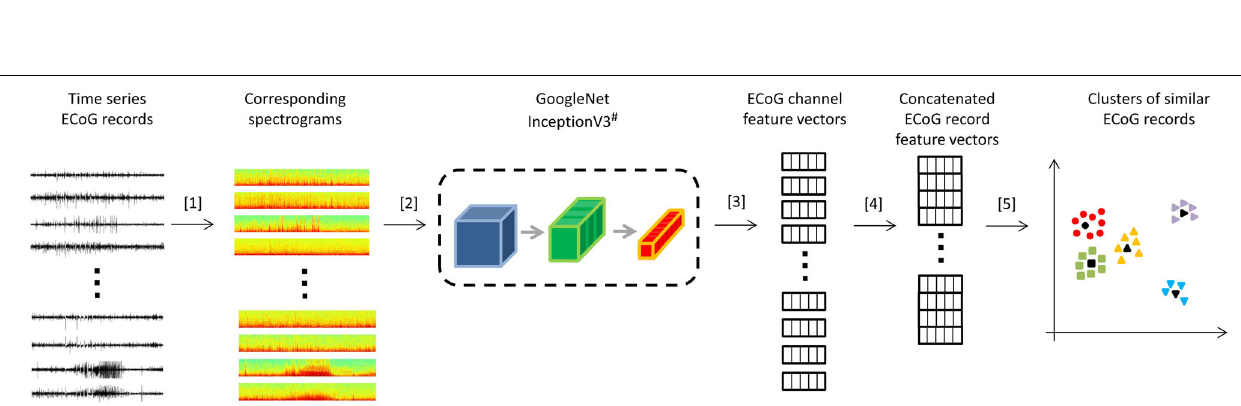
FIGURE 3 | Examples of spectrogram images of ECoG channels. Top row (A) shows examples of spectrogram images computed from electrocorticographic (ECoG) channels manually labeled as ‘electrographic non-seizure.’ Bottom row (B) shows examples of spectrogram images computed from ECoG channels labeled as ‘electrographic seizure.’